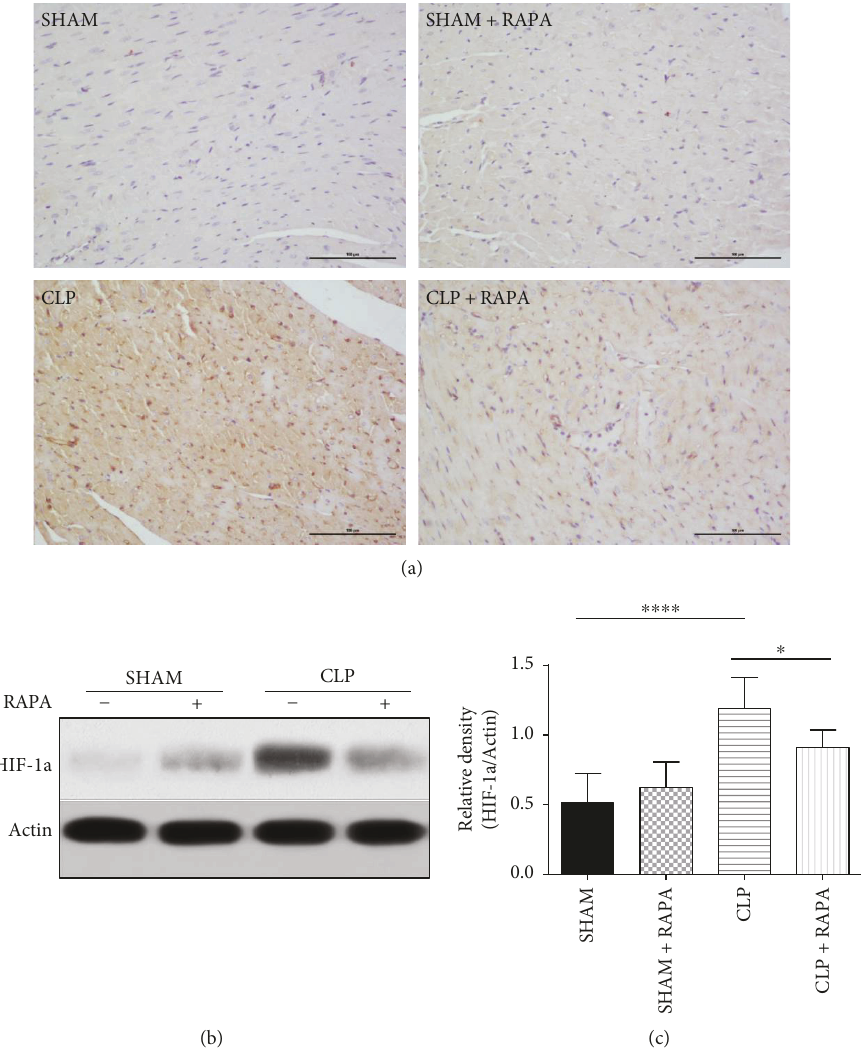
Figure 3: E ff ects of rapamycin on HIF-1a in the left ventricle 18h after CLP. (a) The left ventricle sections stained with an anti-HIF-1a antibody. Magni fi cation, × 200. Bar, 100 μ m. (b, c) Expression of HIF-1a in the left ventricle. The left ventricle was harvested at 18h after CLP, and HIF-1a protein levels were quanti fi ed by western blotting. Mean ± SD, six rats per group, ∗ p < 0 05 ; ∗∗∗∗ p < 0 0001